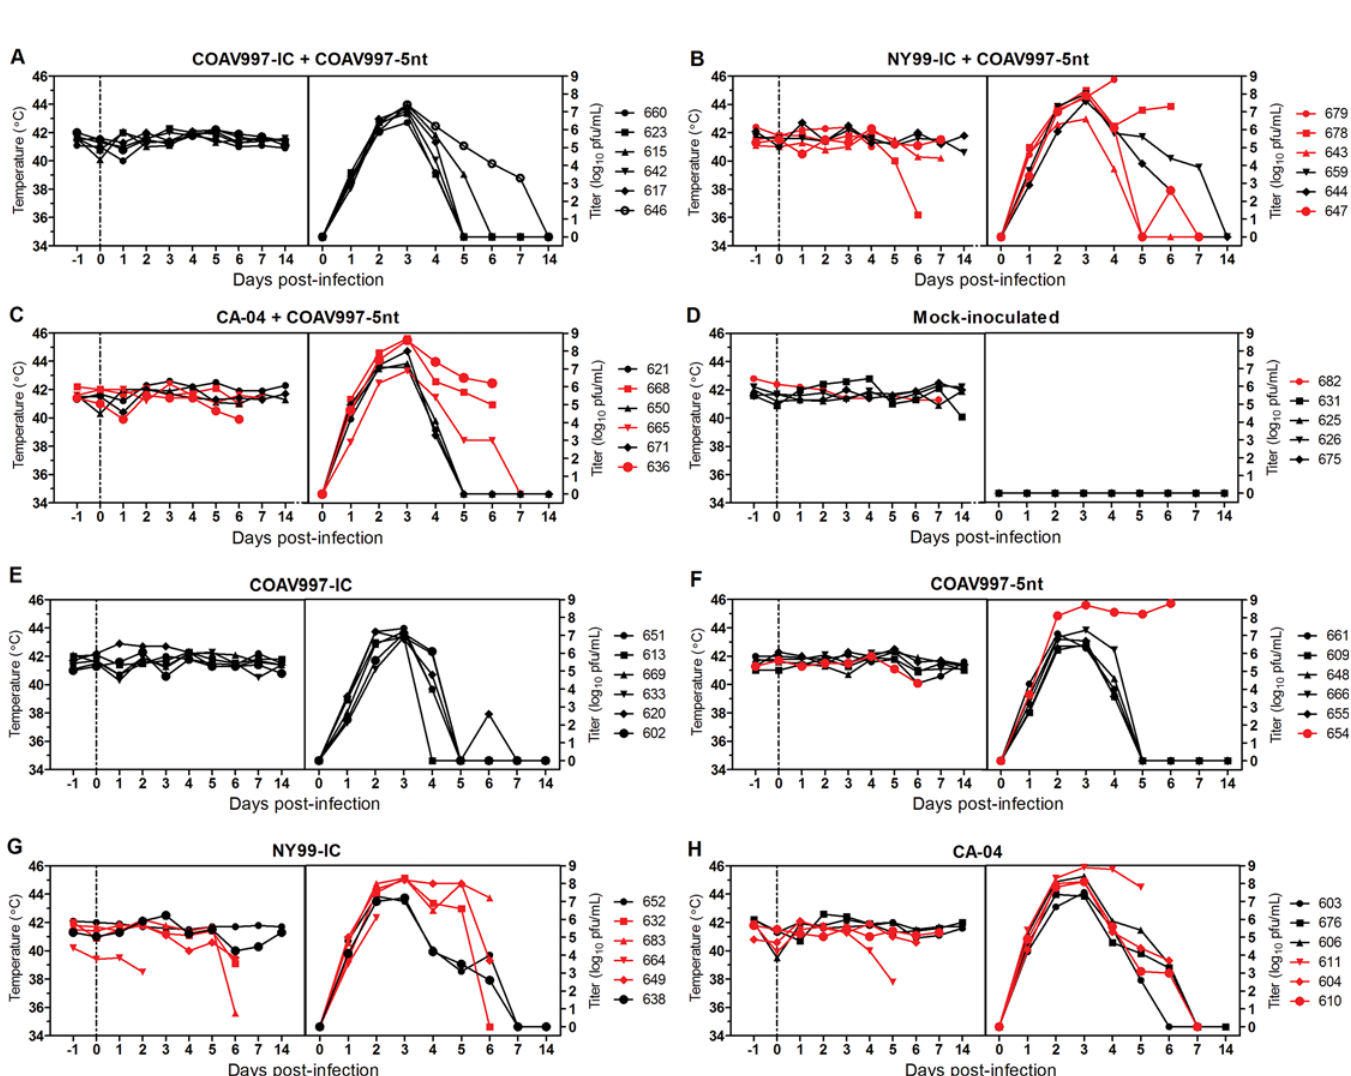
Fig 1. Body temperatures and viremia in HOFIs. Cloacal body temperatures in °Celsius are presented on the left y-axis and viral titers in serum on the right y-axis for each group (A-H) with days post infection (dpi) on both x-axes. Cloacal body temperatures were recorded daily starting one day prior inoculation until 7 dpi and again on 14 dpi. Day 0 and the dotted line represent the day of inoculation. A total of 100 μ L of blood was obtained daily from jugular venipuncture between 1 and 7 dpi and on 14 dpi and mixed in DMEM diluent to obtain a serum dilution of 1:10 after centrifugation. Viral titers were determined by plaque assay titration and are presented as log 10 PFU/mL after accounting for the 1:10 dilution. Red lines indicate HOFIs that died before the end of project day (14 dpi) and these animals were also used to calculate mortality in Fig 4.